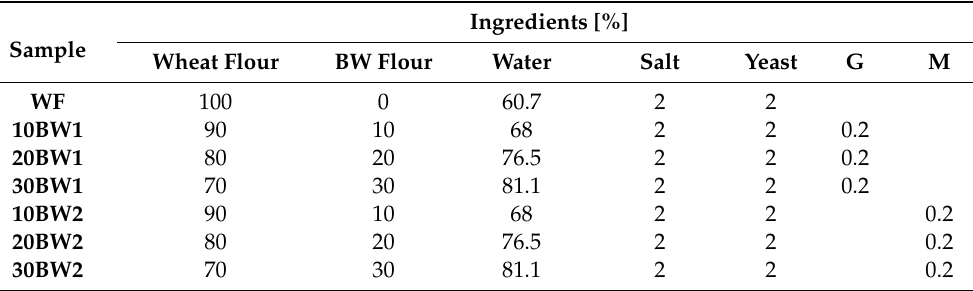
Table 1. Buns recipe by adding buckwheat flour.